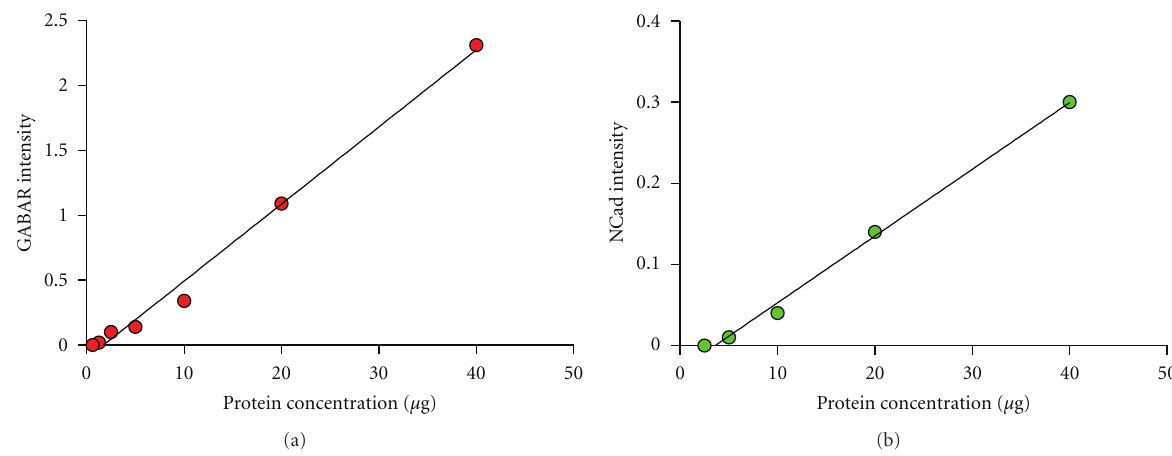
Figure 2: Quantitative Western Blot linear ranges for each protein. (a) GABA A R protein band fluorescent intensity corresponding to a protein dilution curve, 680 nm laser at a scanning intensity of 4 ( R 2 = 0 . 9916). (b) NCad protein band fluorescent intensity corresponding to a protein dilution curve, 800nm laser at a scanning intensity of 3 ( R 2 = 0 .